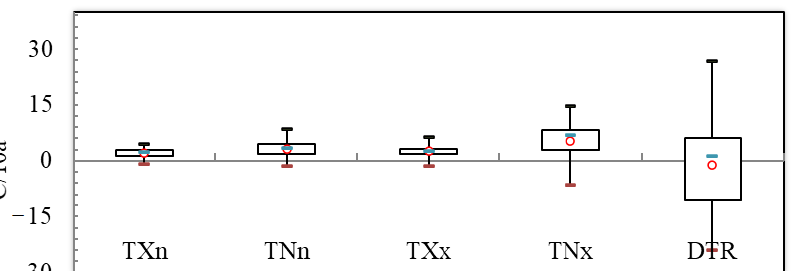
Figure 12. Box-plot of extremal indices. At the top of the box-framed figure is the lower quartile value of the sequence, and at the bottom is the upper quartile value. Unit: TXn, TNn, TXx, TNX, DTR (°C/10a).